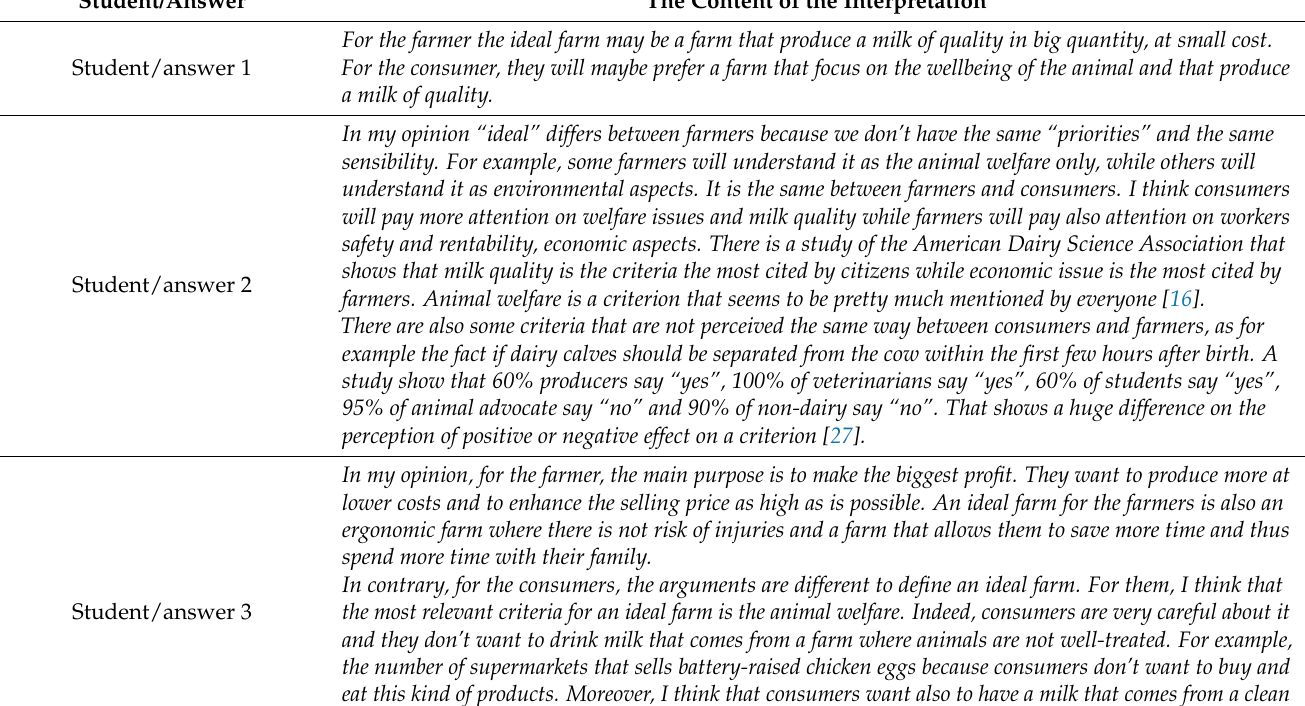
Table 4. Student responses to the question: In your opinion, the understanding of an “ideal” dairy farm may differ between farmers (dairy farm owners) and consumers? Justify the answer. Student/Answer The Content of the